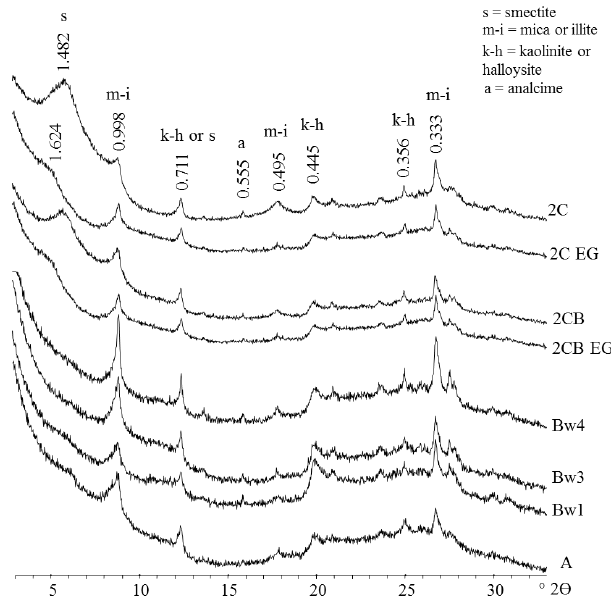
Figure 6. XRD patterns of untreated and treated (where EG is ethy- lene glycol solvated) clay samples separated from soil horizons along soil profile P2. Peak positions are in